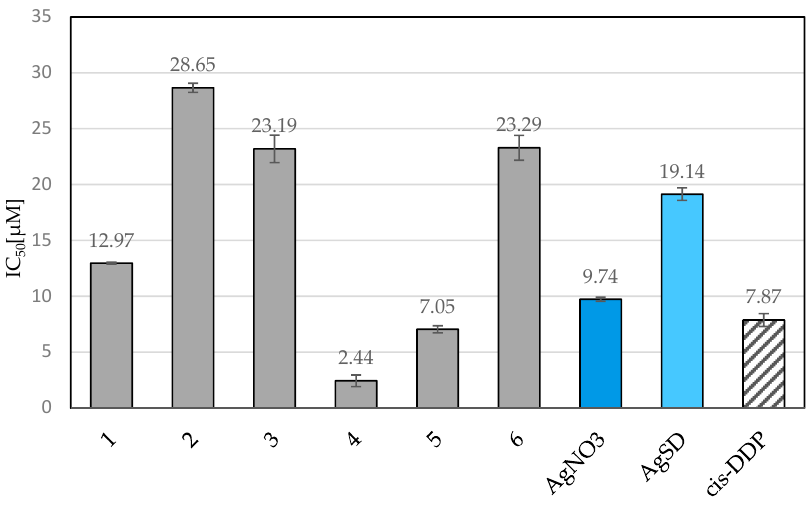
Figure 5. Response of B16 cell lines to silver complexes 1 – 6 , AgNO 3 , AgSD (silver sulfadiazine) and cis -DDP (cisplatin). Values presented are IC 50 (µM) ± SD for three independent experiments. The IC 50 values of complexes 1 – 6 range from 244 to 2865 µM. Complexes 4 and 5 demonstrate the highest cytotoxicity against B16 cells, with respective IC 50 values of 2.44 and 7.05 µM. The activity of complex 4 is four times greater than that of AgNO 3 and eight times greater than AgSD. Complex 5 demonstrates slightly greater cytotoxicity than AgNO 3 and about twice as much as AgSD. Moreover, complex 5 exhibits IC 50 value in the same range as cisplatin, whose IC 50 value is 7.87 µM, whereas complex 4 is three-fold higher in IC 50 value compared to cisplatin. Though complexes 4 and 5 contain different heterocyclic rings, i.e. , pyridine and benzimidazole, they both include the hydroxymethylene groups, the presence of which may determine the activity of the complexes.